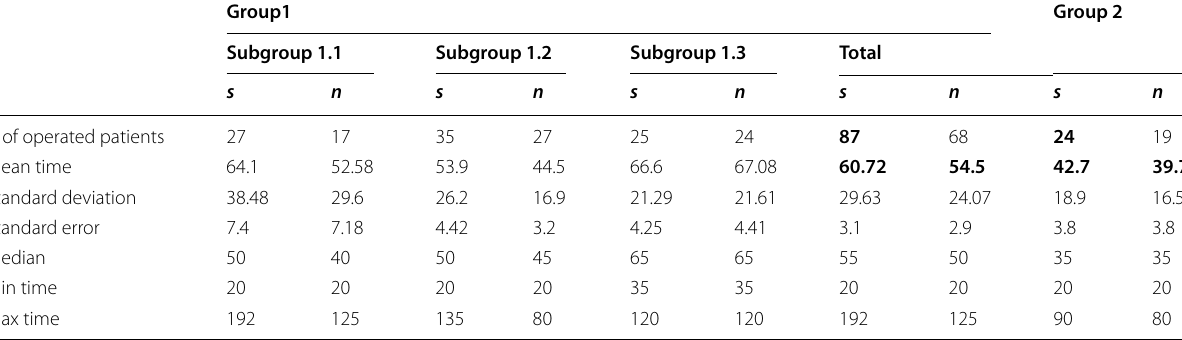
Subgroups: s total number of patients (incl. s imultaneous operations), n number of patients without ( n o) simultaneous operations